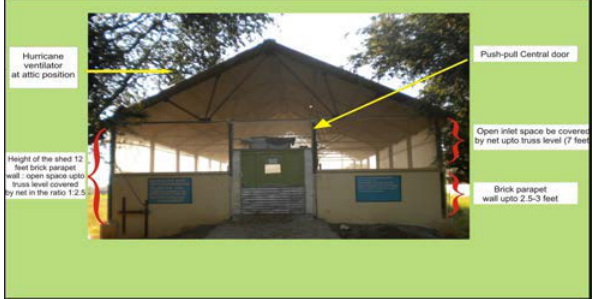
Figure-1: Front view of gable type fly proof net shed.